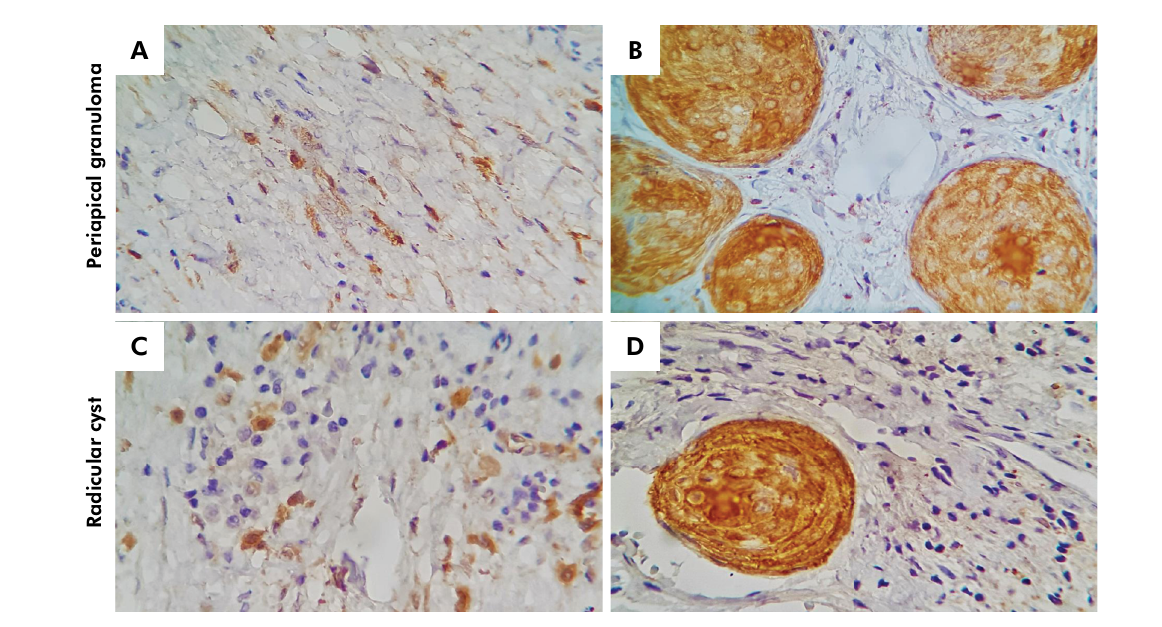
Figure 2. Photomicrographs of ALDH-1 immunoexpression in mesenchymal cells present in lesion capsules. (A) Periapical granuloma capsule. (C) Radicular cyst capsule. (B, D) Presence of odontogenic epithelium remains inside the capsule showing ALDH-1 immunoexpression, both in the periapical granuloma and radicular cyst (A-D: IHC, ×40).